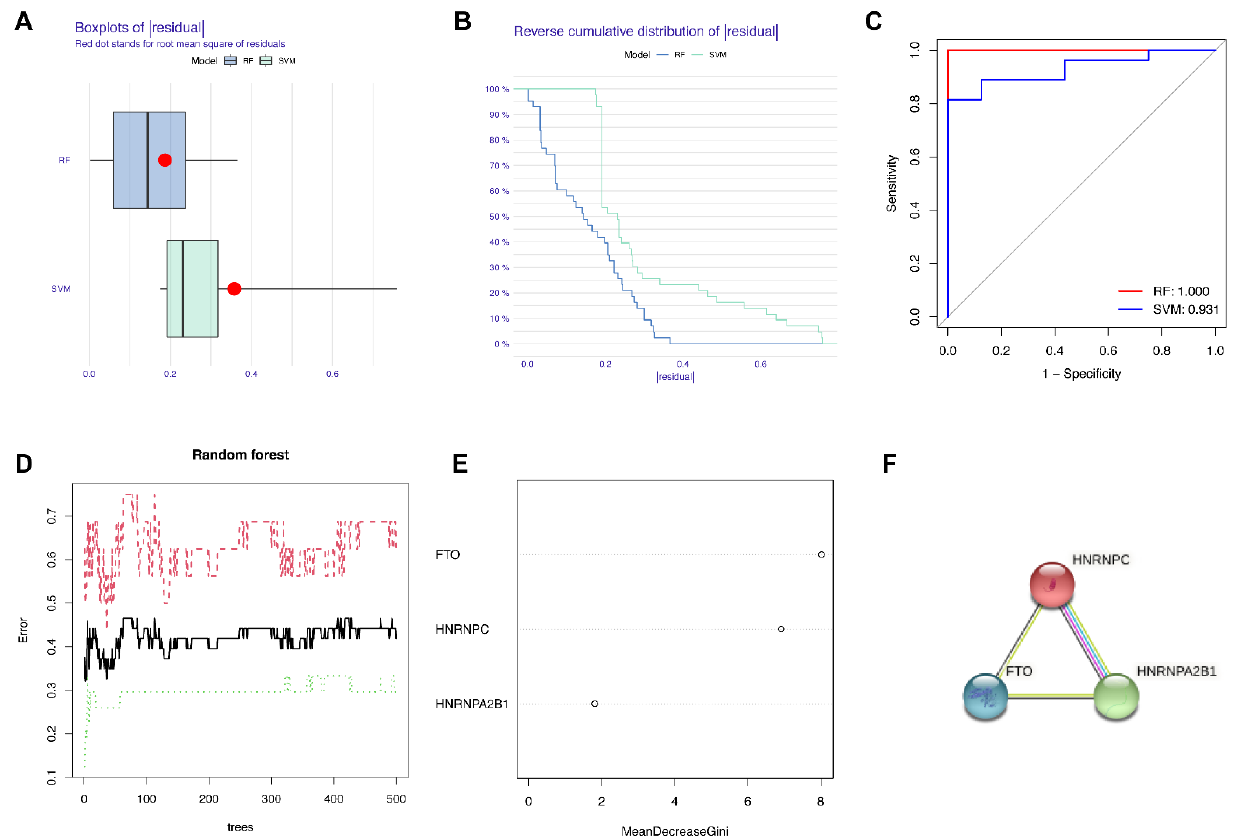
Figure 4. Construction of the RF model of m6A regulators and the PPI network of candidate genes. ( A ) Boxplots of residual. ( B ) Reverse cumulative distribution of residual. ( C ) The ROC curve indicated the accuracy of the SVM and RF models. ( D ) The tree numbers of random forest. ( E ) The importance of significant genes. ( F ) The PPI network of significant genes.